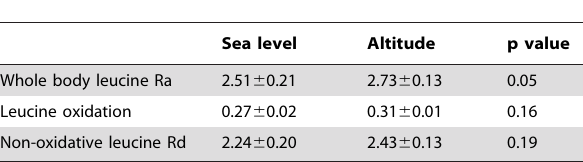
Table 1. Whole body leucine